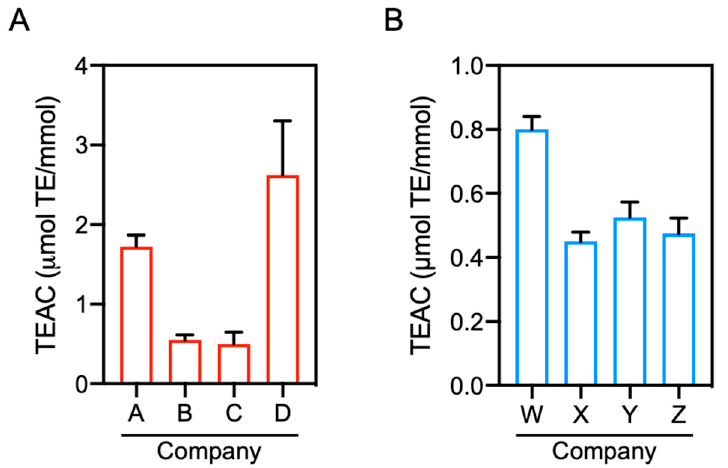
Figure 3. Comparison of the antioxidant capacity of commercial IDPs. The antioxidant capacity was evaluated by DPPH radical scavenging assay in the presence or absence of commercial carnosine ( A ) and anserine ( B ) standards (final 1.25–50 mM). Data are expressed as TEAC and are presented as means ± SEM ( n = 4).